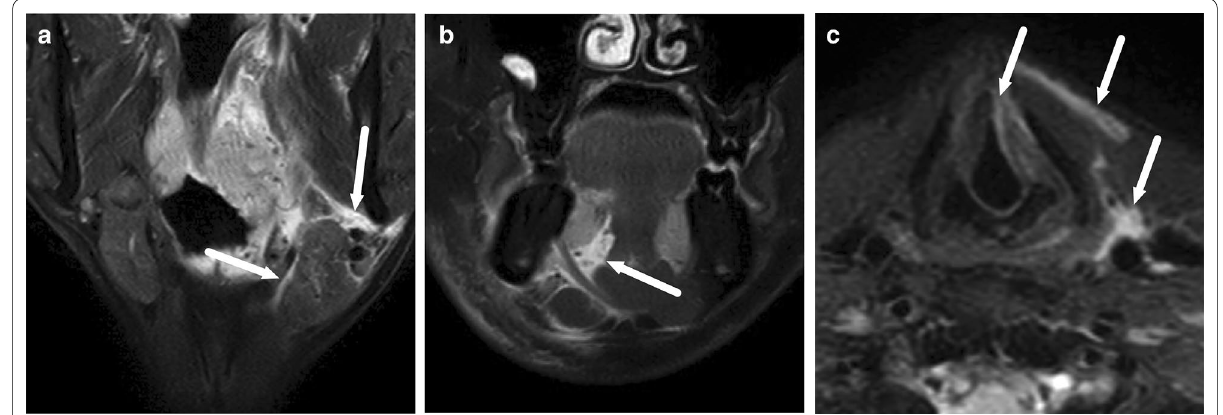
Fig. 11 Examples of SMSE ( a ), SLSE ( b ), and VSE ( c ) on coronal ( a , b ) and axial ( c ) fat-suppressed T2-weighted images